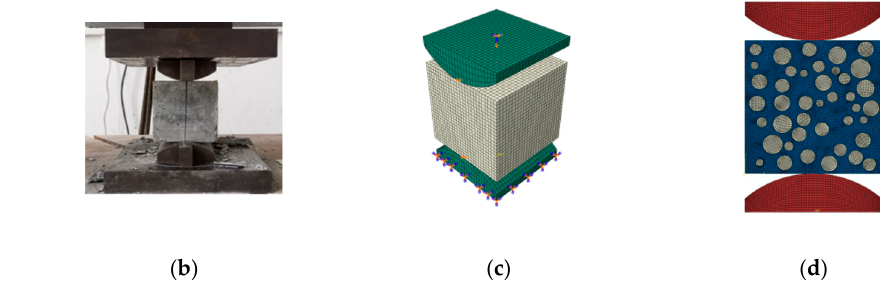
Figure 6. Split tensile strength test: ( a ) schematic diagram, ( b ) physical diagram, ( c ) inclusion model, and ( d ) 2D random model.